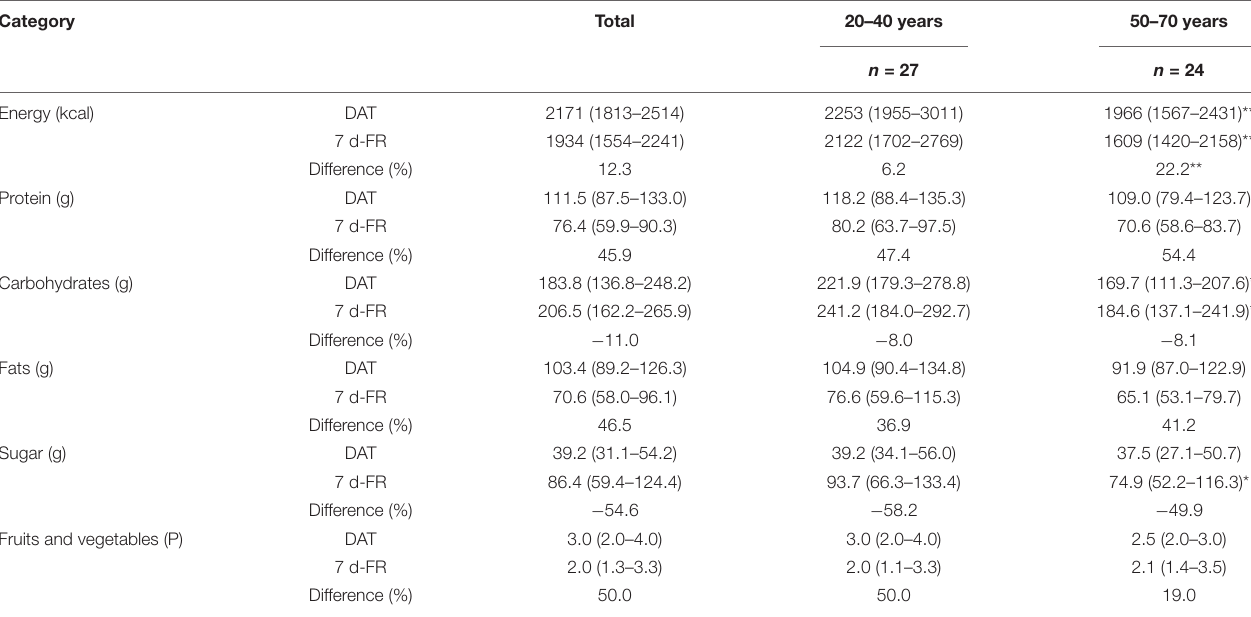
TABLE 1 | Energy intake by macronutrients and group.